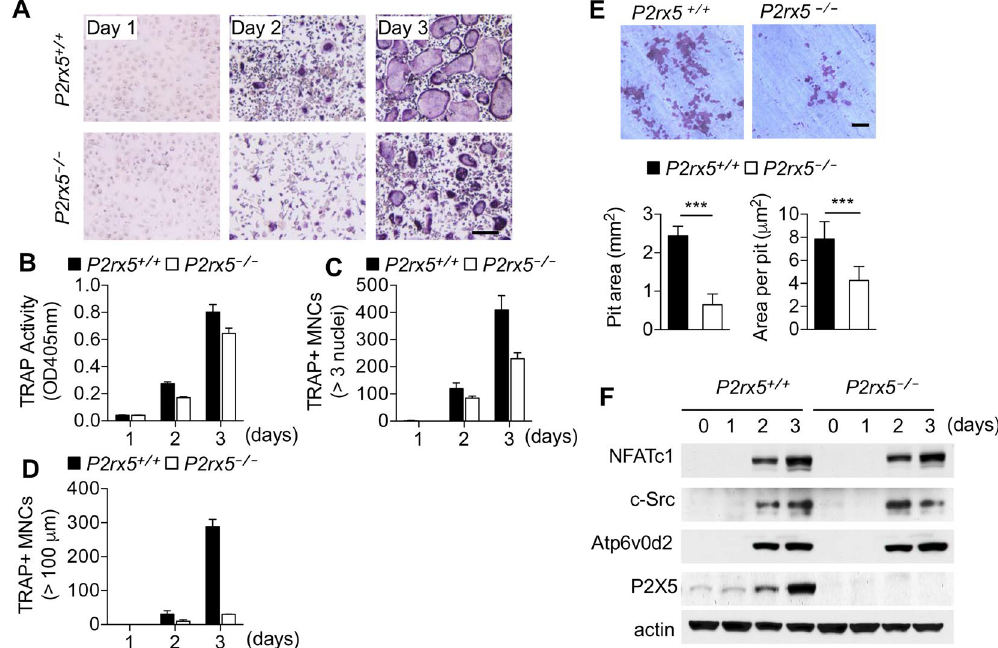
Figure 4. P2rx5 deficiency suppresses in vitro OC maturation. ( A–D ) P2rx5 + / + and P2rx5 − / − BMMs were cultured for the indicated times in the presence of M-CSF and RANKL. ( A ) Bright-field images of OCs stained for TRAP and ( B ) quantitation of TRAP activity in OCs measured at OD405nm. TRAP + MNCs were enumerated both by ( C ) the presence of more than 3 nuclei and ( D ) cell size larger than 100 μ m in diameter. Scale bar represents 100 μ m. ( E ) Bone resorption activity of P2rx5 + / + and P2rx5 − / − during OC differentiation. BMMs were cultured on dentine slices for 3 days with M-CSF and RANKL to induce OC differentiation, then OCs were further incubated for 2 additional days, and pit areas analyzed. Resorption area (left plot) and resorption area per OC (right plot). Scale bar represents 200 μ m. *** P < 0.001. Data are shown as means ± SD. ( F ) Western blot analysis of NFATc1, c-Src, Atp6v0d2 and P2X5 expression during osteoclast differentiation. Lysates were made at indicated time points from P2rx5 + / + and P2rx5 − / − OC cultures. Probing against actin was performed for